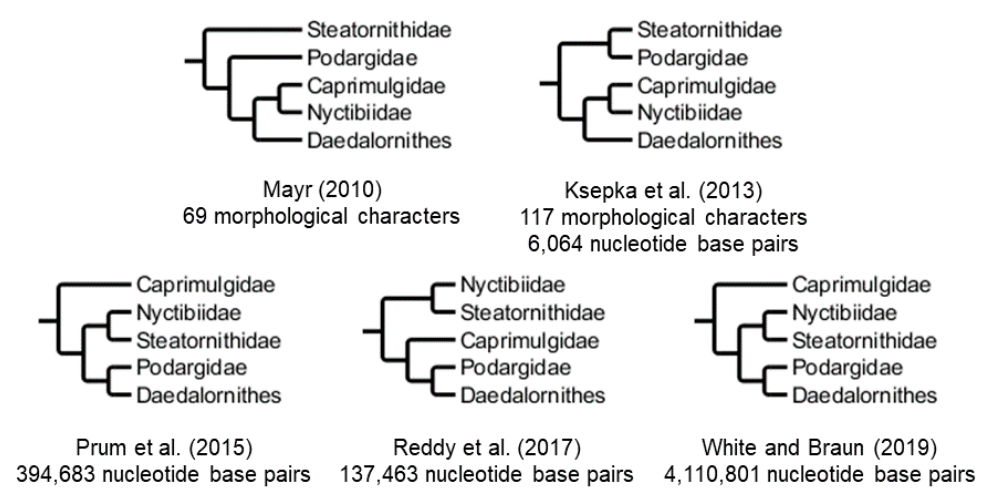
Figure 1. Alternative hypotheses for the phylogenetic topology of Strisores suggested by previous